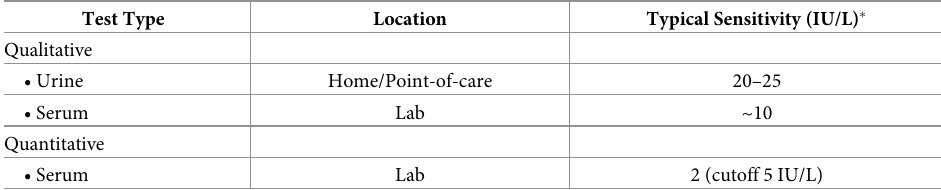
Table 2. Pregnancy test